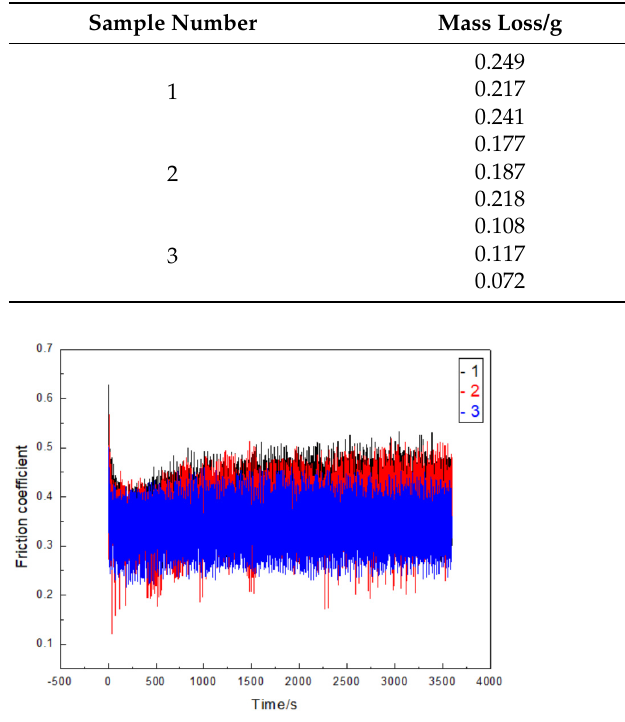
Figure 12. Diagram of friction coefficients.